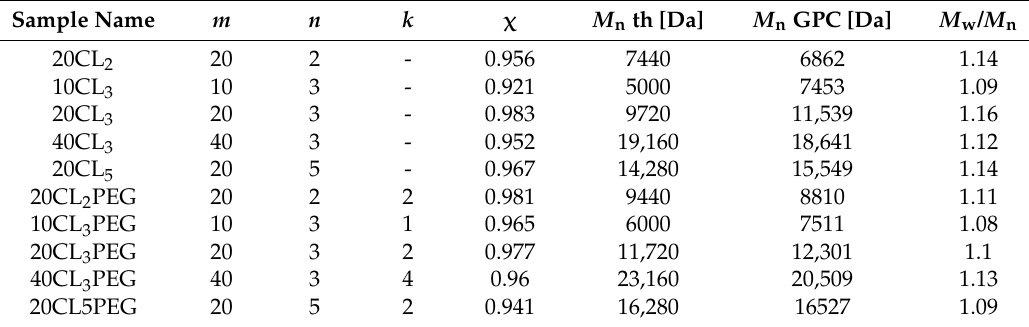
Table 1. Characterizations for the first class ( m CL n ) and second class ( m CL n PEG) of polymers.